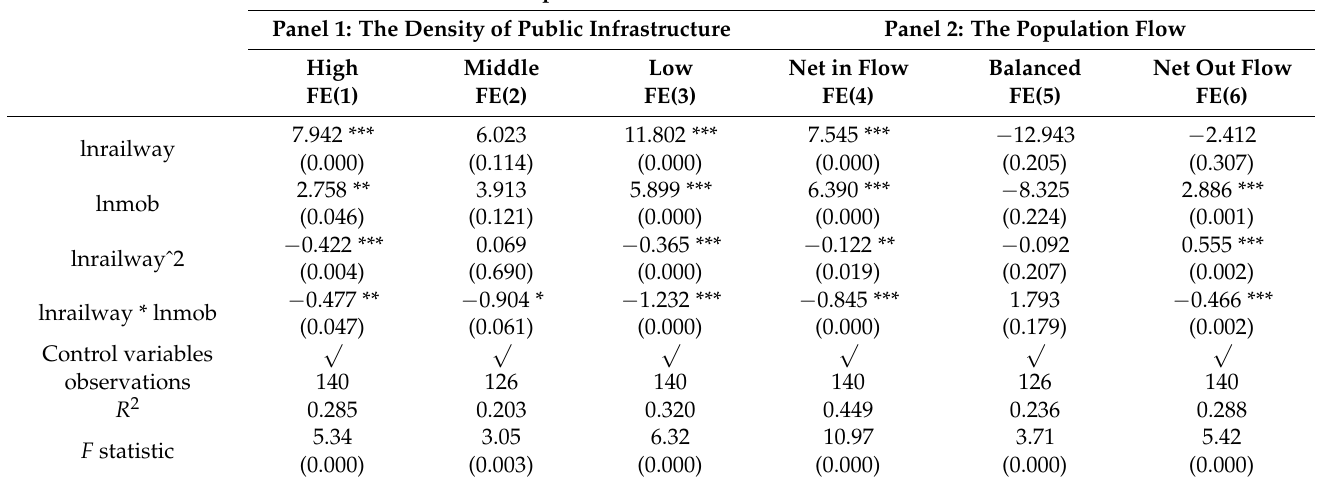
Table 3. Heterogeneity analysis. Dependent Variable: Incidence of Infectious Disease Panel 1: The Density of Public Infrastructure Panel 2: The Population